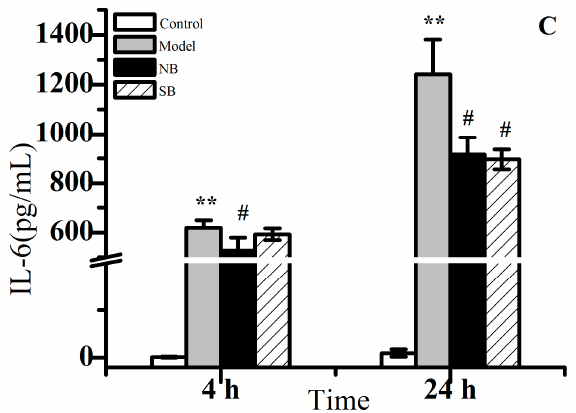
Figure 3. The release of NO ( A ); TNF- α ( B ) and IL-6 ( C ) in lipopolysaccharide (LPS)-induced RAW 246.7 macrophages after being treated by NB and SB for 4 h and 24 h. Note: VS control group, ** p < 0.01; vs. model group, # p < 0.05 and ## p < 0.01.